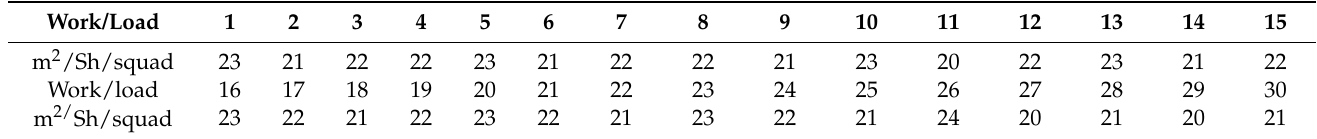
Table 3. Ceiling formwork—performance m 2